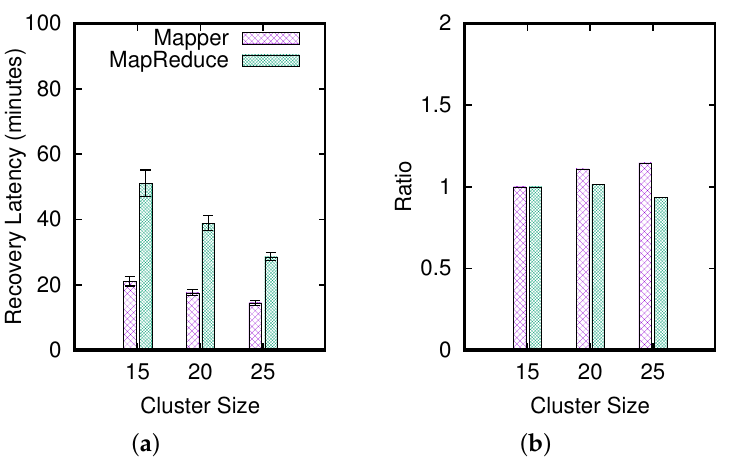
Figure 8. Effects of varying the cluster size (the ratio of 20-node source/shadow/destination cluster to 10-node